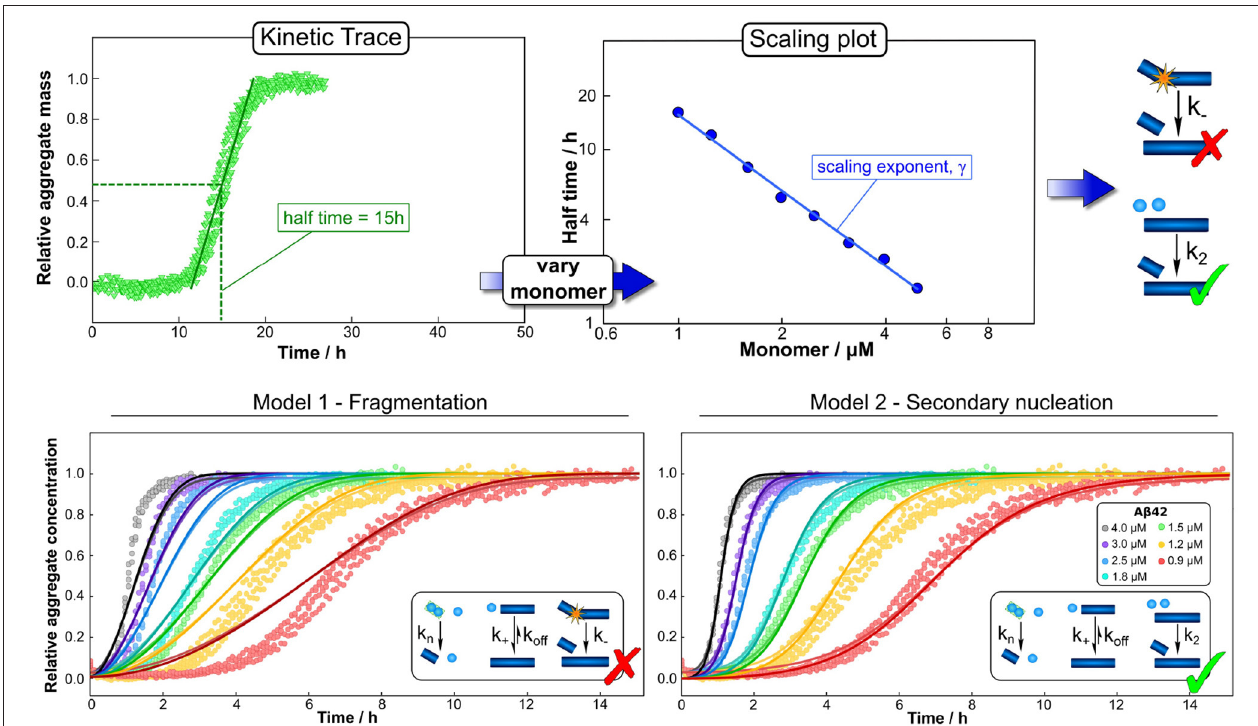
FIGURE 3 | Global fitting and the use of scaling to determine mechanisms. Varying a number of different experimental parameters is crucial for determining possible mechanisms. In particular, variations of the monomeric protein concentration can provide important mechanistic insights due to the differing dependence of different mechanisms on monomer concentration. A powerful and easy way to apply this technique in practice is the use of scaling exponents, which describe how a representative quantity of the aggregation reaction, such as the half time, varies with the monomer concentration. (Top) The half time can easily be extracted from kinetic traces. Plotting the half time against monomer concentration then allows the determination of the scaling exponent and exclusion of mechanisms that are inconsistent with the observed scaling. Often scaling exponents alone already allow the qualitative determination of mechanisms (here an example in which fragmentation can be excluded simply based on the scaling exponent). (Bottom) To then quantify the rates and confirm mechanisms, one performs a global fit, i.e., using one set of parameters to describe the entire dataset at all monomer concentrations, of the integrated rate laws derived for different models (points are experimental measurements of aggregate amounts, solid lines the best global fit of the model shown in the schematic, different colors denote different protein concentrations). Here the fits confirm the conclusions from the scaling analysis, that a fragmentation dominated mechanism is inconsistent with the data while a secondary nucleation dominated mechanism describe it well. Adapted from Meisl et al. (2016a,